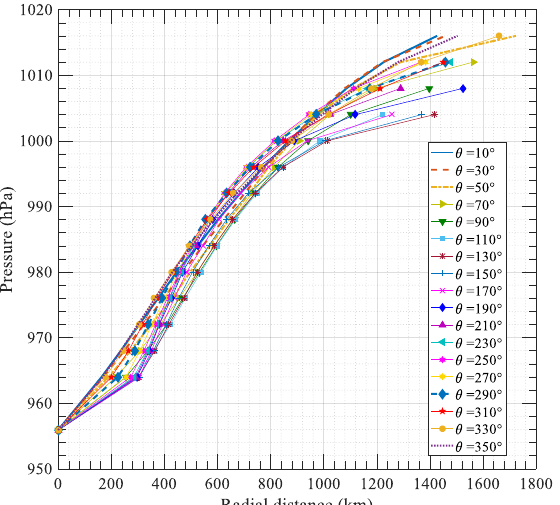
Figure 2. Radial profiles of the composite pressure inside ETC at various azimuthal locations .